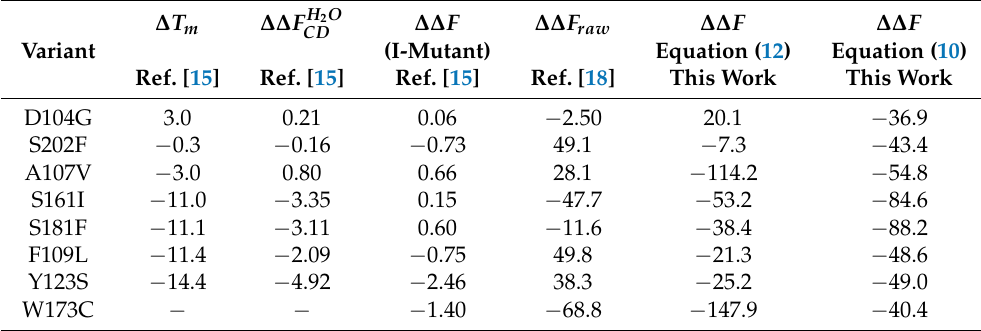
Table 3. Experimental ( ∆ T m , C ◦ ) and ∆∆ F (kcal/mol) compared to predictions reported in the literature and in this work. Rows are reported in descending order of ∆ T m .